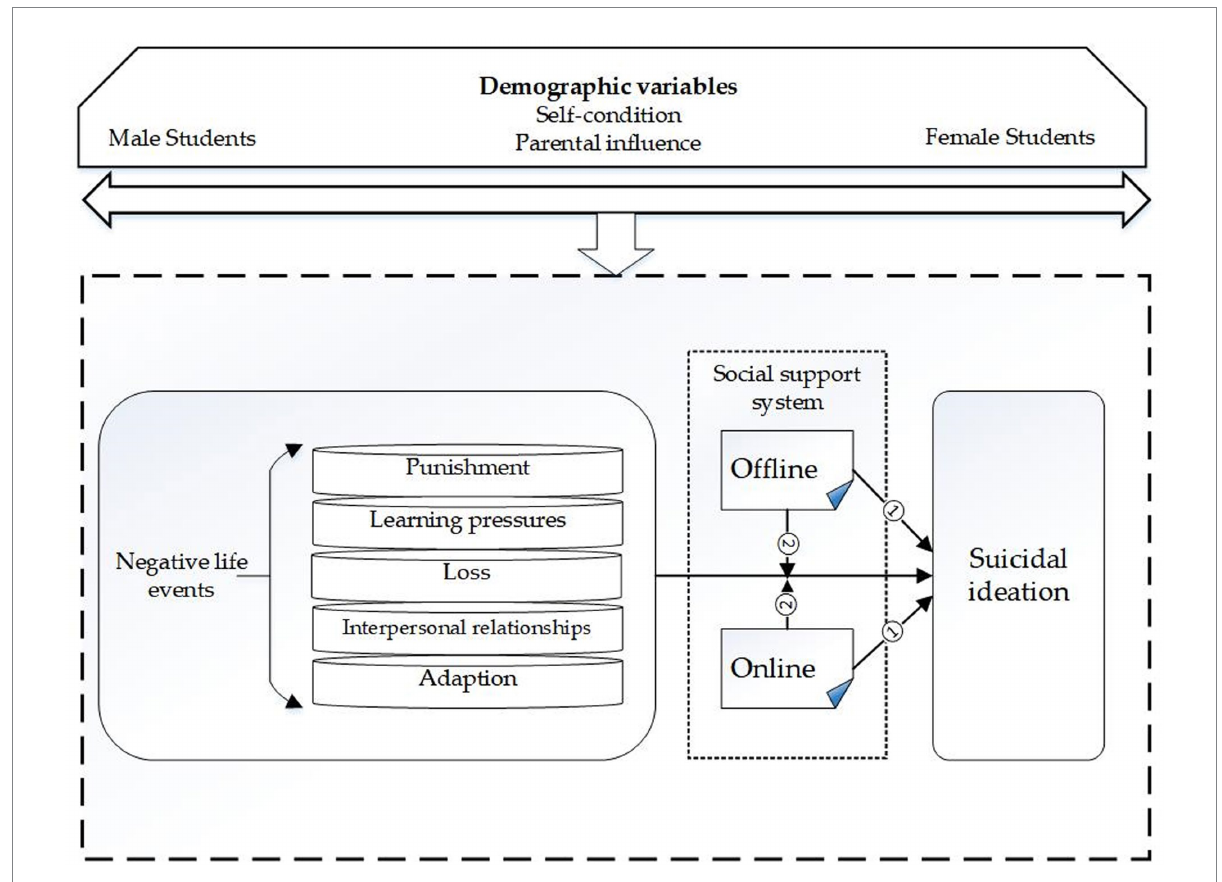
FIGURE 1 The direct and moderating effects of offline and online social support on suicidal ideation among youth under the pressure of negative life events (Path